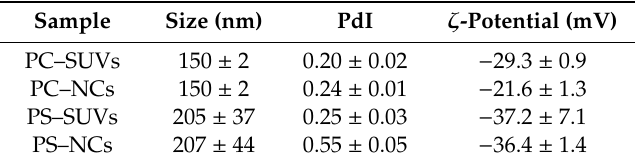
Table 1. Physical characterisation of empty liposomes and nanocochleates.